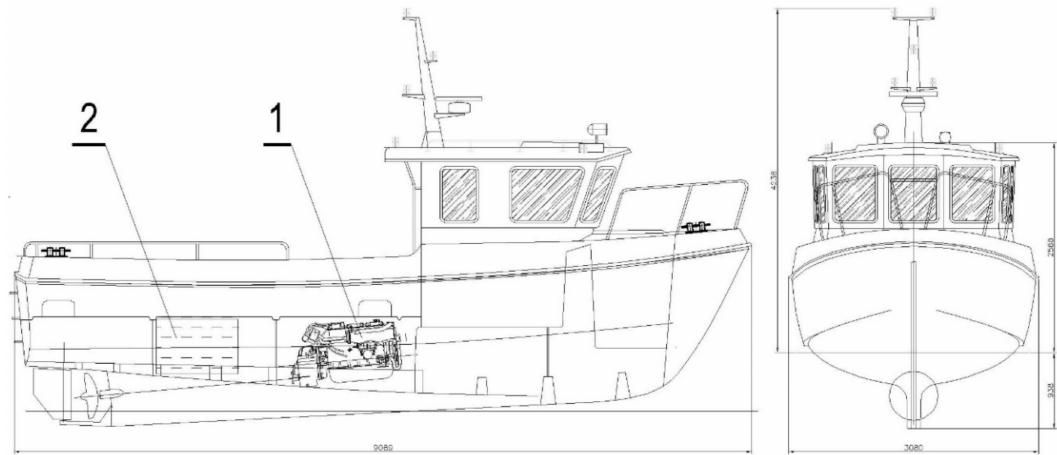
Figure 1. Conrad-900 vessel—general view; 1—combustion engine with reduction gear, 2—fuel